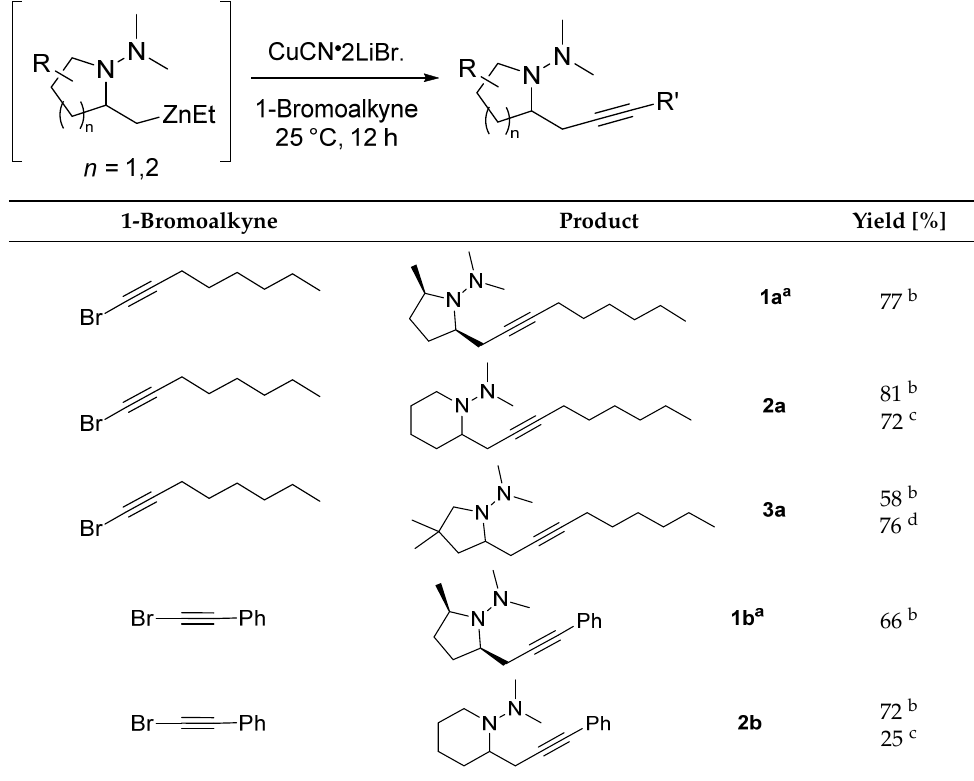
Table 1. Results of the cross-coupling of 1-bromo-1-octyne and 1-bromo-2-phenylethyne with N,N- dimethylhydrazinoalkenes 1 , 2 , and 3 .